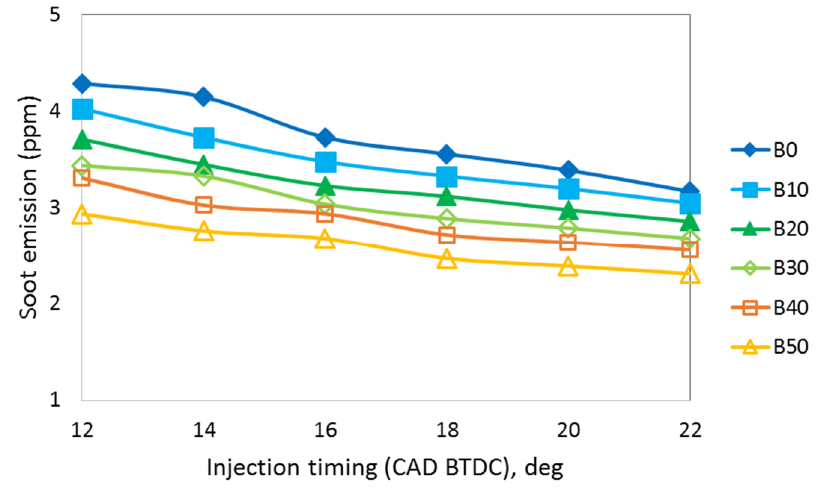
Figure 18. Effect of injection timing on engine Soot emission.